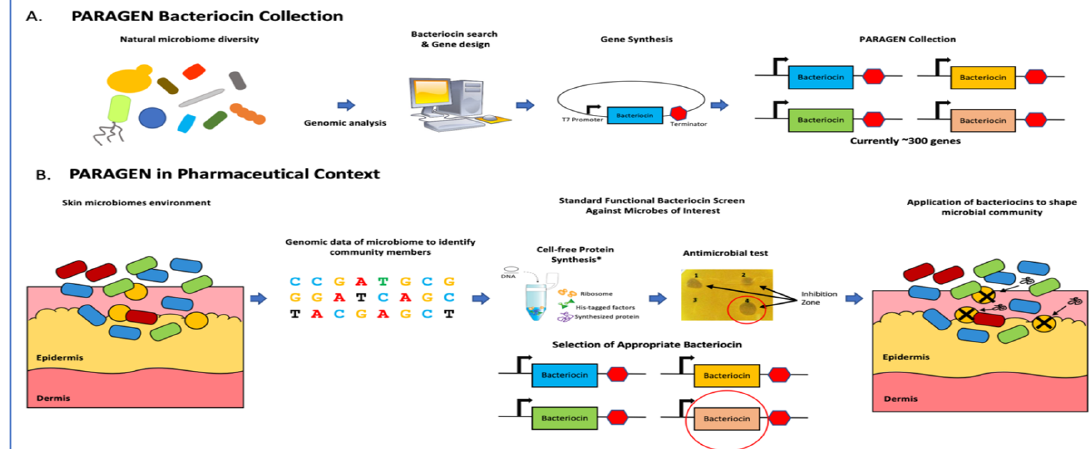
Figure 2. Application of narrow-spectrum antimicrobial peptides to shape microbial populations. ( A ) The PARAGEN collection is a standardised collection of bacteriocins previously described in Gabant